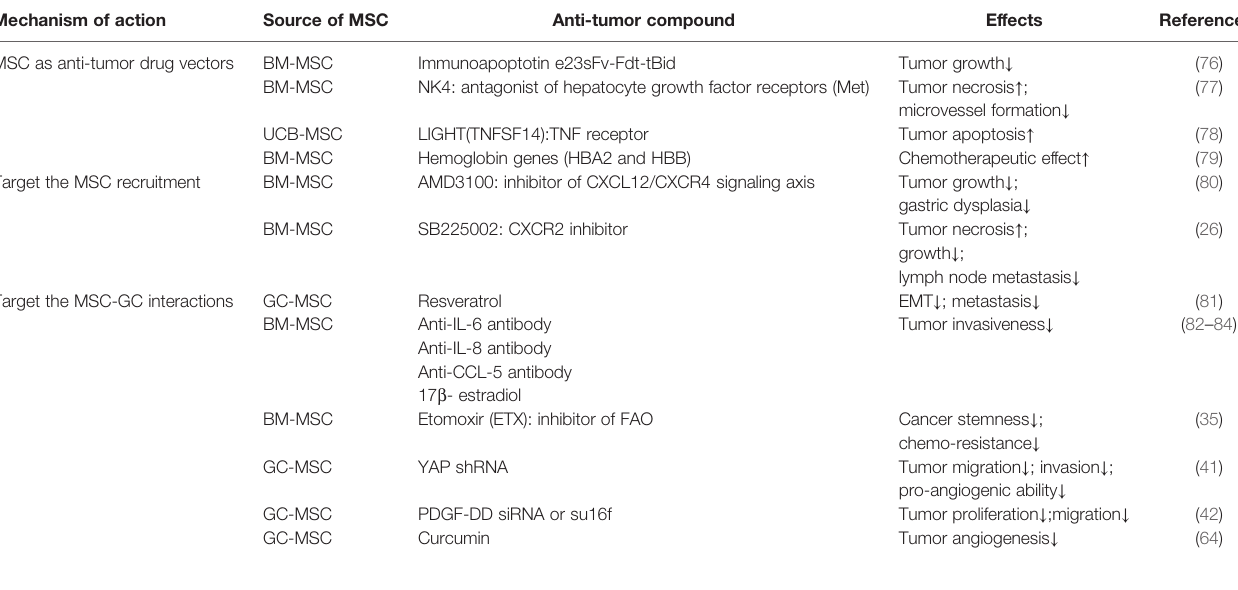
TABLE 1 | Summary of applications of MSC in targeted therapy of